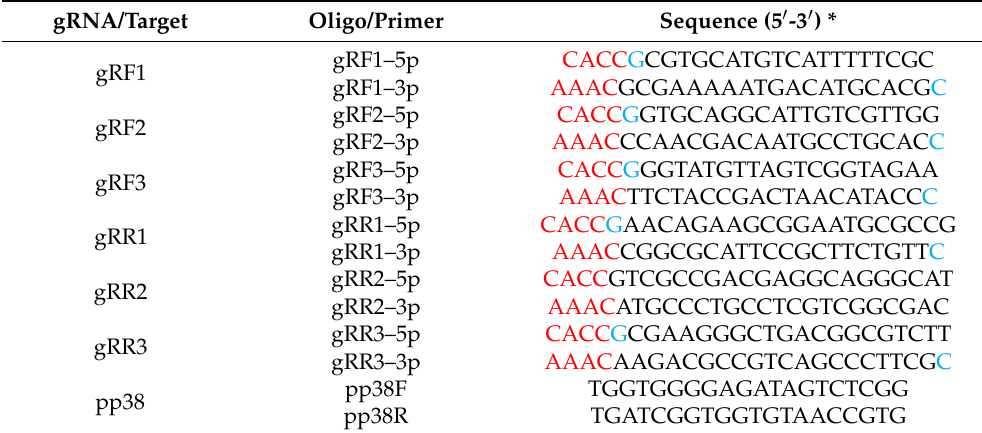
Table 2. Oligos and primers used for making gRNA plasmids or PCR identification of pp38-deleted MDV mutants.